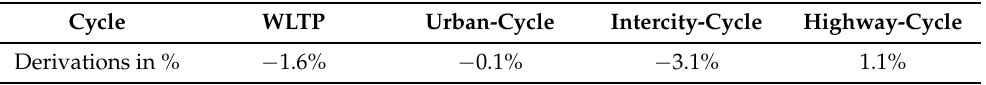
Table 4. Derivations between the battery output energy consumption of the simulation and the corresponding measurement in %. Cycle WLTP